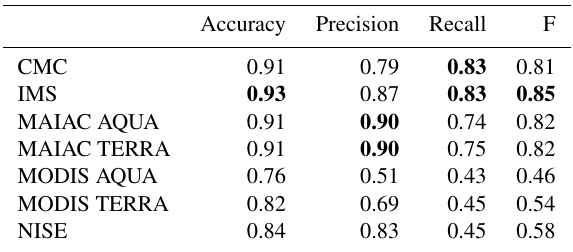
Figure 4. Number of false positive (FP) and false negative (FN) snow attributions by the snow data sets in 2015. All data sets are evaluated at 4km resolution. Total number of false snow attributions inset. White space indicates that no ground stations present. Table 1. Evaluation of daily snow extent data set performance for 2015. GHCN-D surface observations are used as “truth”. All prod- ucts are regridded to a common 4km resolution. The highest value for each metric is shown in bold.